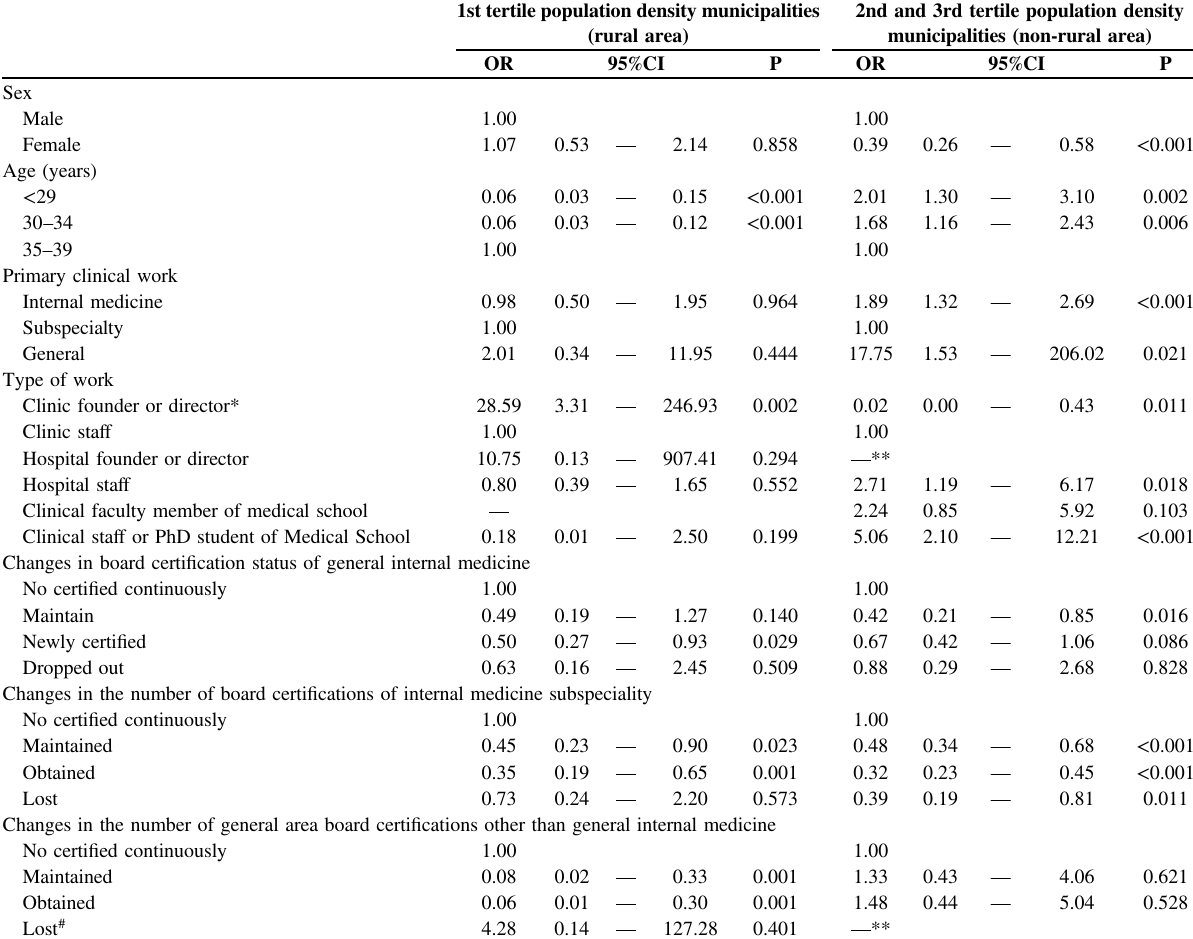
Table 4-1 ORs for working at rural area among IM doctors aged under 40